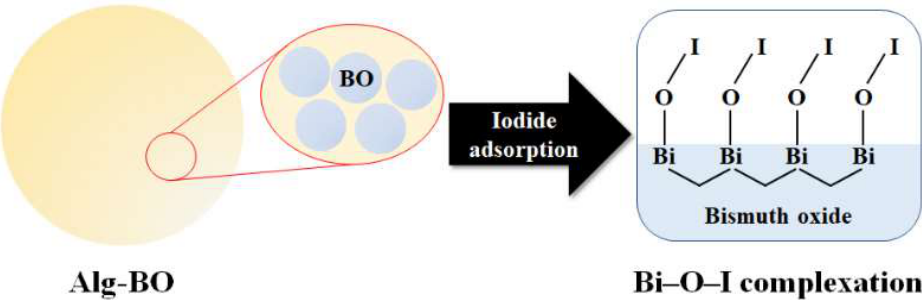
Figure 10. Schematic adsorption mechanism between Alg–BO and iodide.